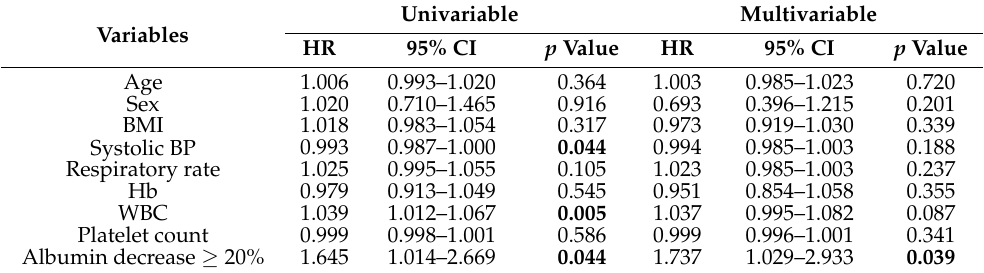
Table 6. Prognostic impact of albumin decrease within uni- and multivariable Cox regression analyses.